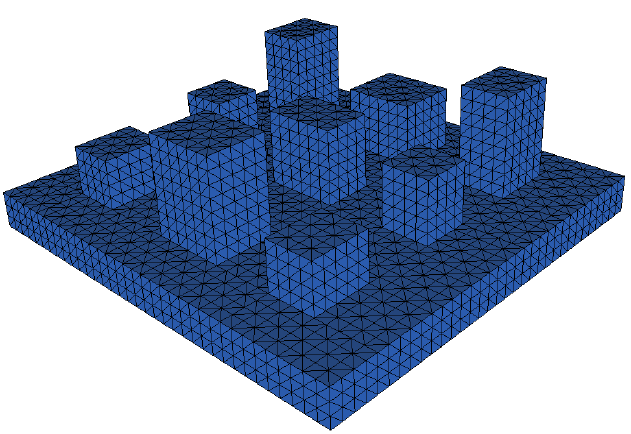
Figure 2. Geometrical configuration of the solid domain (soil and buildings, 6622